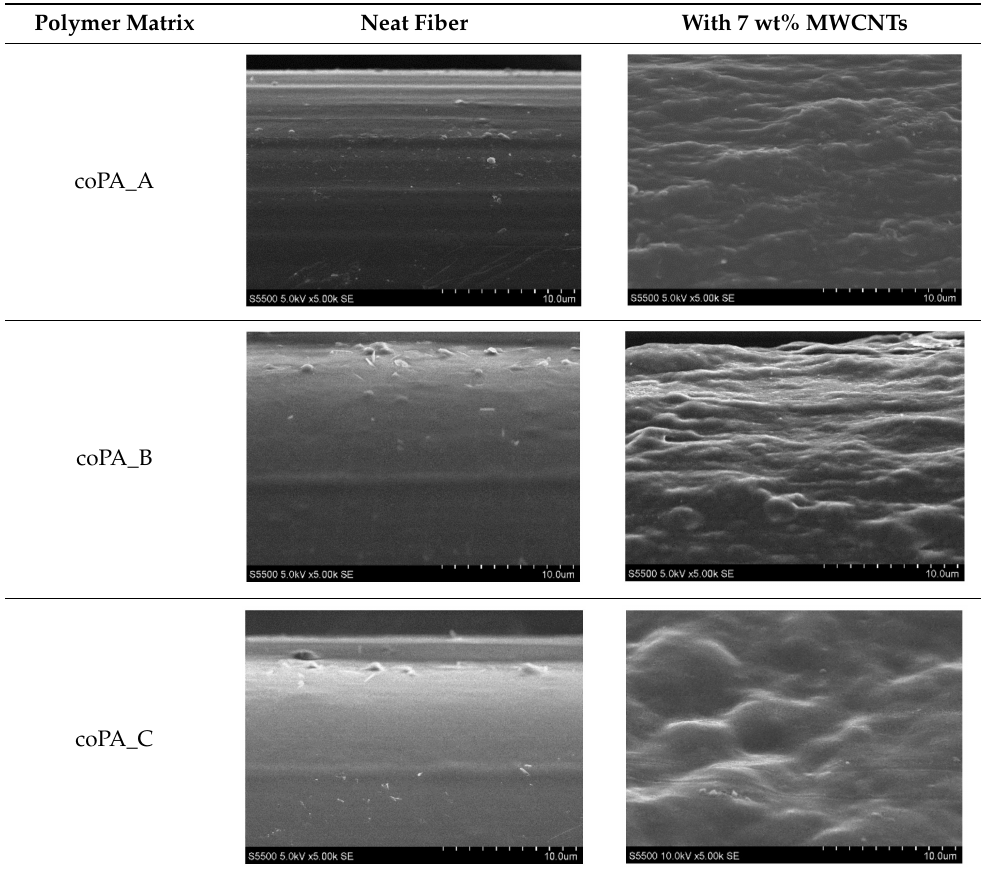
Table 3. The comparison of the surface of fibers fabricated from neat copolyamides and from copolyamides containing 7 wt%